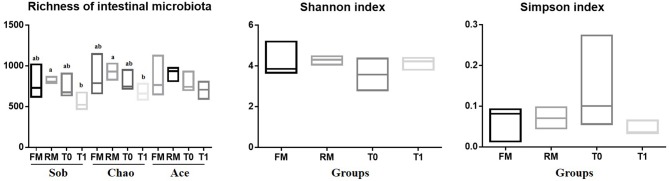
Alpha diversity results of intestinal digesta microbiota of grass carp. The richness and diversity of the microbial community in a single sample were revealed by α-diversity analysis, different letters indicate significant differences among four groups (P < 0.05); values with no letter mean no significant difference (P > 0.05).